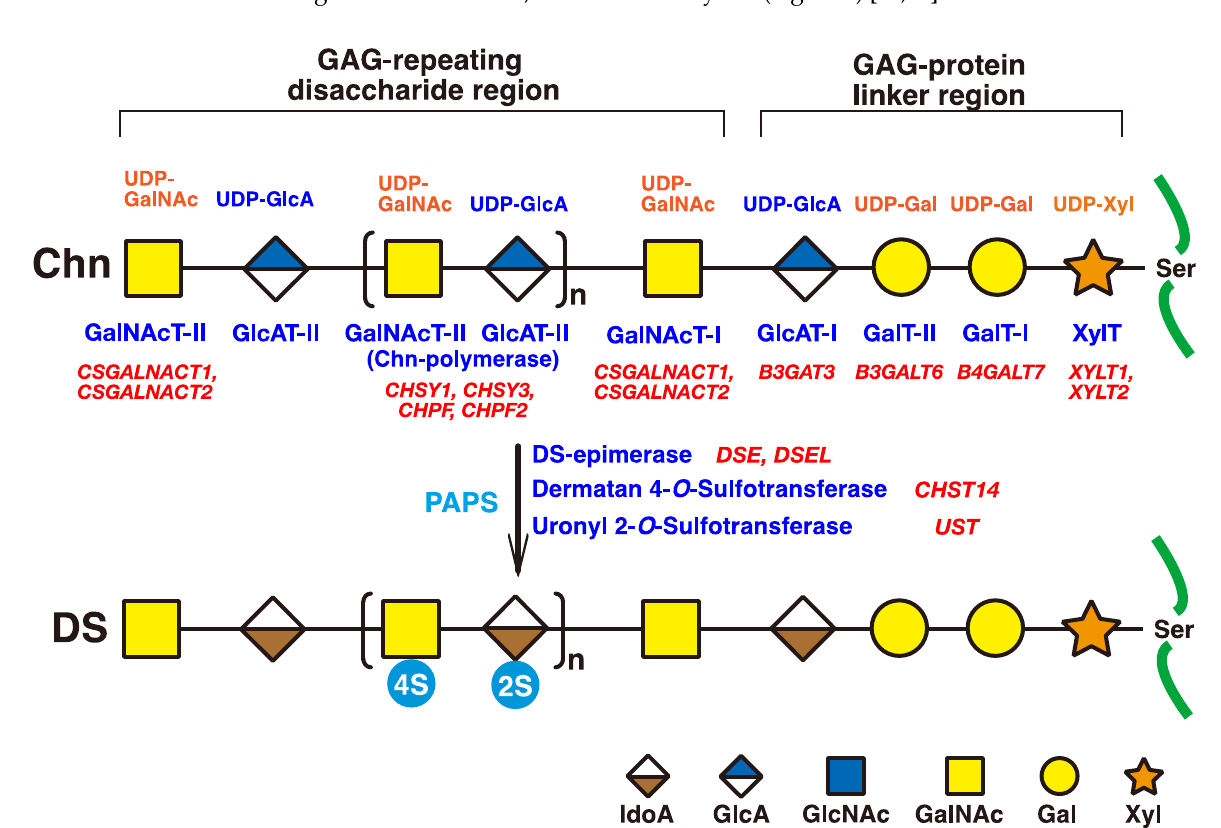
Figure 2. Schematic presentation of biosynthesis of the DS chain. All glycosyltransferases require a corresponding UDP-sugar, such as UDP-Xyl, UDP-Gal, UDP-GlcA, and UDP-GalNAc, as a donor substrate. After specific core proteins have been translated, the GAG-protein linker region, GlcA- Gal-Gal-Xyl-, is constructed by XylT, GalT-I, GalT-II, and GlcAT-I. The fifth sugar moiety, GalNAc, is then transferred to the GlcA residue in the linker region by GalNAcT-I, thereby resulting in the formation of the repeating disaccharide region, [-GlcA-GalNAc-] n , which is the unsulfate backbone of CS, by Chn-polymerase that is formed by a hetero complex of any CHSY1, CHSY3, CHPF, or CHPF2. Then, DS-epimerase converts GlcA into IdoA by epimerizing the C-5 carboxy group in the chondroitin precursor, which results in the formation of the repeating disaccharide region of dermatan, [-IdoA-GalNAc-] n . After formation of the dermatan backbone, each sugar residue is modified by sulfation and catalyzed by sulfotransferases, as indicated in the figure. D4ST or UST transfers a sulfate group from PAPS to the C-4 position of the GalNAc or to the C-2 position of the IdoA residues in the dermatan chain, respectively. It should be noted that the 4- O -sulfation but not the 2- O -sulfation is predominant. Each enzyme and its coding gene are described under the respective sugar symbols. The abbreviations 2S and 4S stand for 2-O- and 4- O -sulfates, respectively. The chondroitin precursor chain, [-4GlcA β 1-3GalNAc β 1-] n , which is the unsulfate backbone of CS, is built up to the non-reducing terminal GlcA residue of the linker region tetrasaccharide by chondroitin synthase family members, using UDP-GlcA